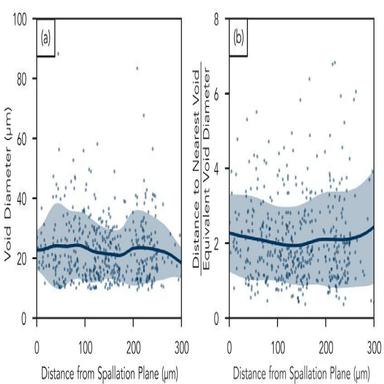
(a) Local average and confidence intervals of the void diameter. (b) Local average and confidence intervals of the ratio between void diameter and the inter-void spacing. Both of these plots were constructed using kernel regression to smooth the data using a Gaussian kernel with σ =15 μm. The confidence interval was calculated as one standard deviation using a kernel regression estimate of - x2 − x2 1/2 .